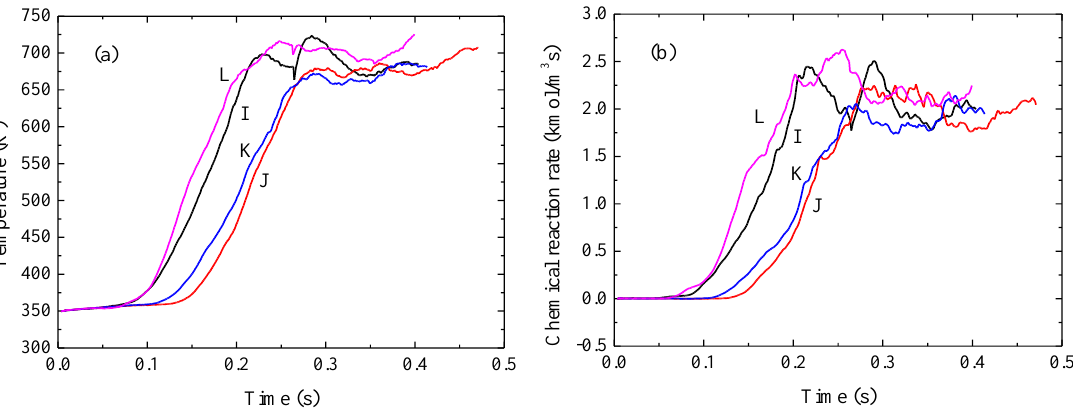
Figure 13. The changes of a combustor ( a ) average temperature and ( b ) chemical reaction rate with time in Case